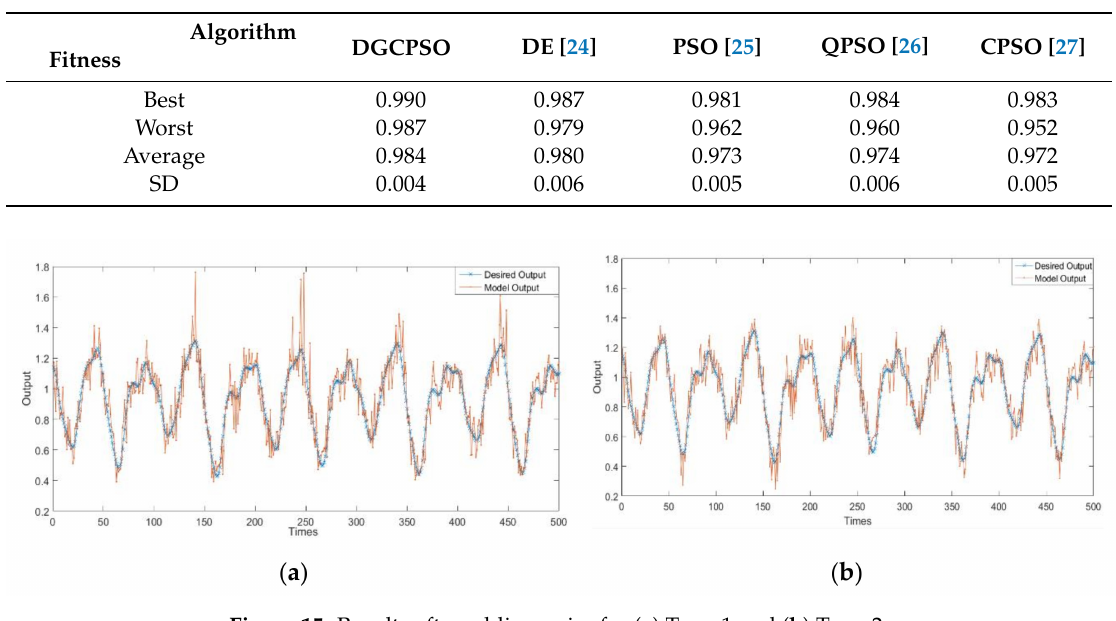
Figure 15. Results after adding noise for ( a ) Type-1 and ( b ) Type-2.